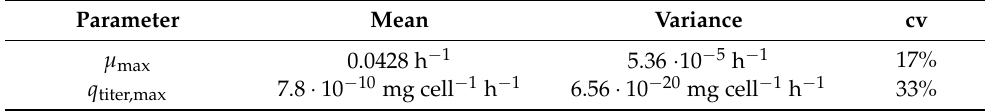
Table 5. Prior parameter values for maximum growth rate µ max (mean, variance and coefficient of variation (cv)) and empirical production rate q titer,max (mean, variance and coefficient of varia- tion